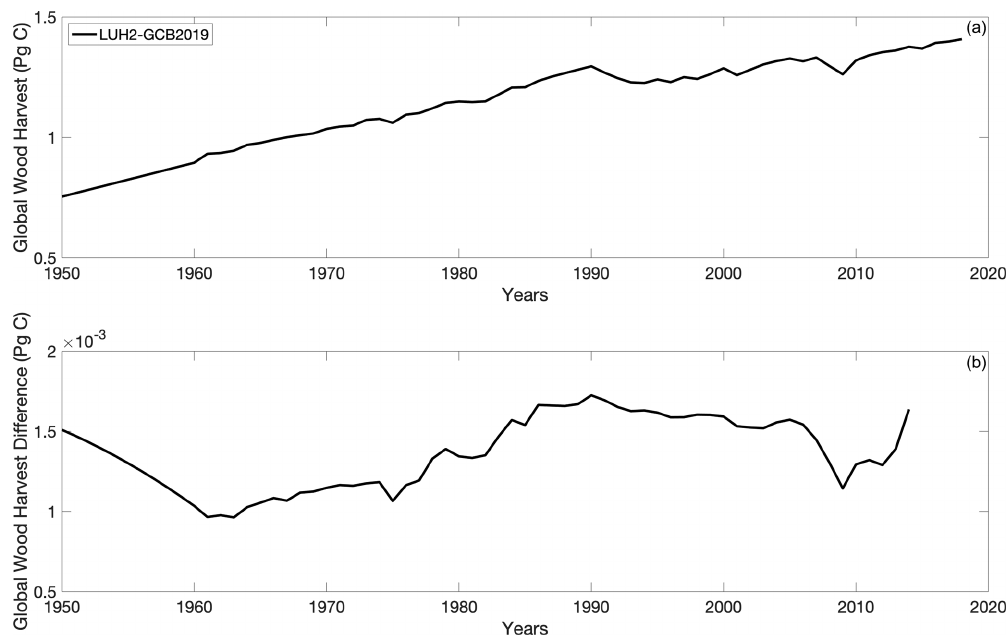
Figure 3. (a) Global wood harvest for LUH2-GCB2019. (b) Difference between global wood harvest of LUH2 v2h and LUH2-GCB2019 (LUH2 v2h – LUH2-GCB2019).